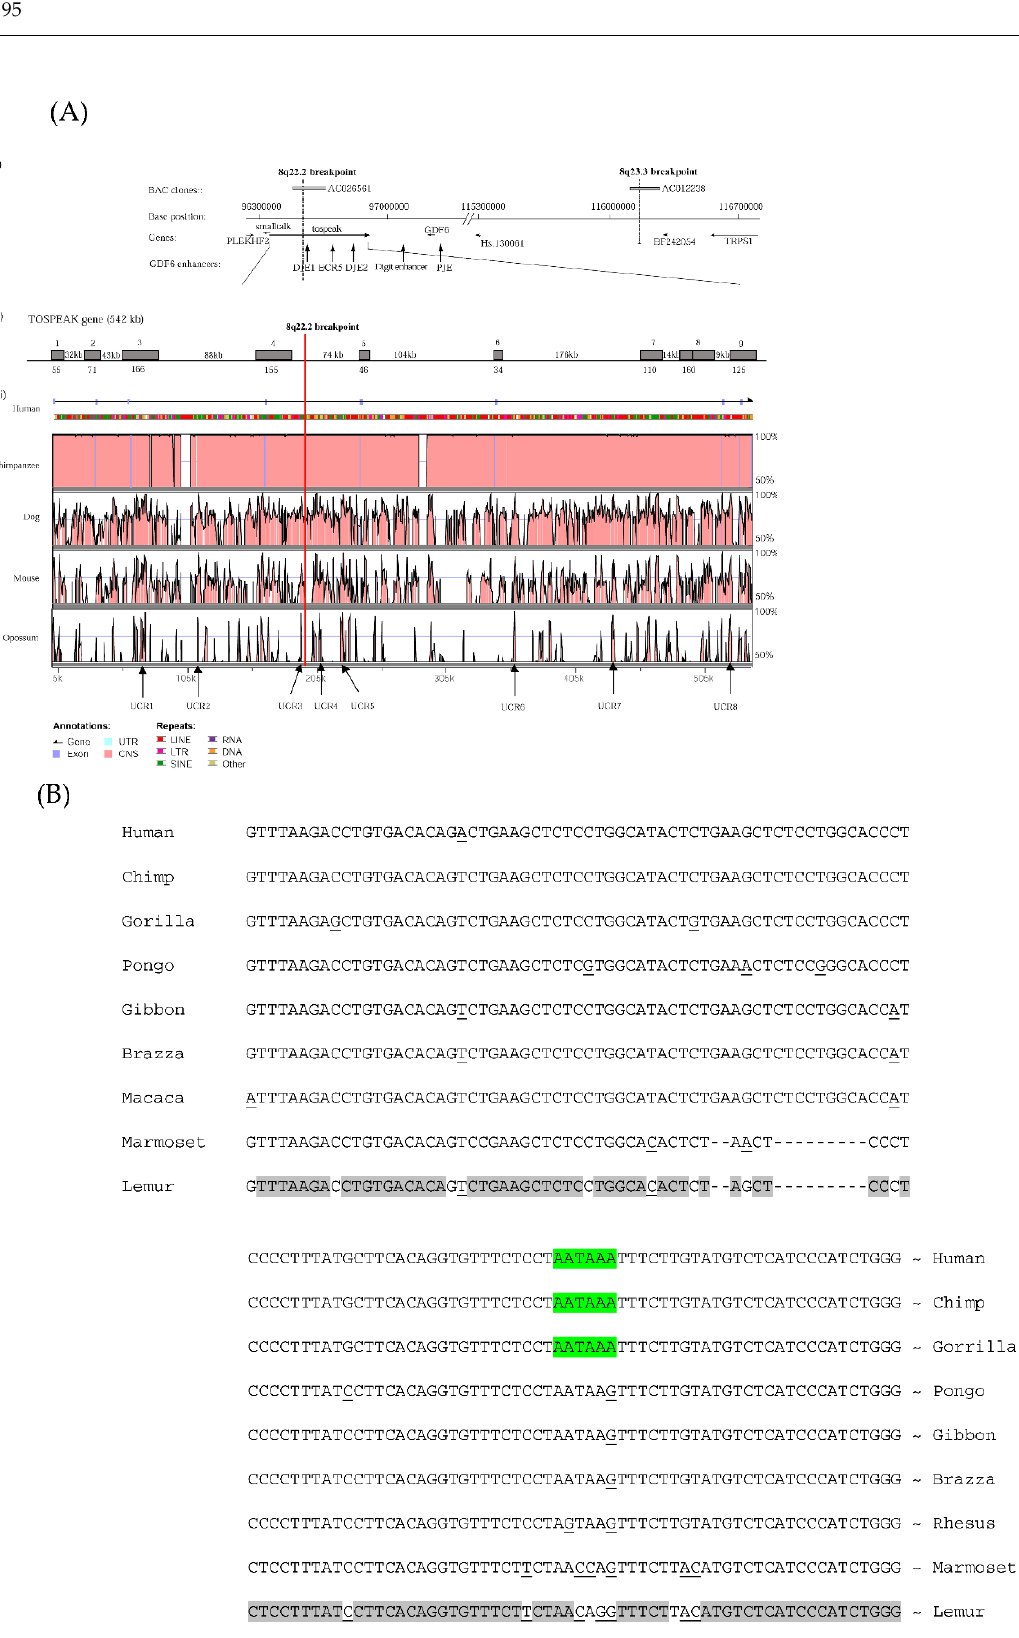
Figure 6. TOSPEAK gene characterisation ( A ) Comparative genomic analysis of the TOSPEAK/C8ORF37AS1[+9] locus ( i ) Schematic view of the genomic region spanning inv(8)(q22.2q23.3) breakpoints in the speech impaired family [14]. Genes (horizontal arrows), GDF6 enhancers (vertical arrows). ( ii ) TOSPEAK gene structure with 8q22.2 break point in the 4th intron. ( iii ) VISTA plot spanning TOSPEAK gene (exons marked blue) for multiple vertebrate species where strict selection criteria were applied for highly conserved regions (HCRs ≥ 200 bp ungapped alignment with